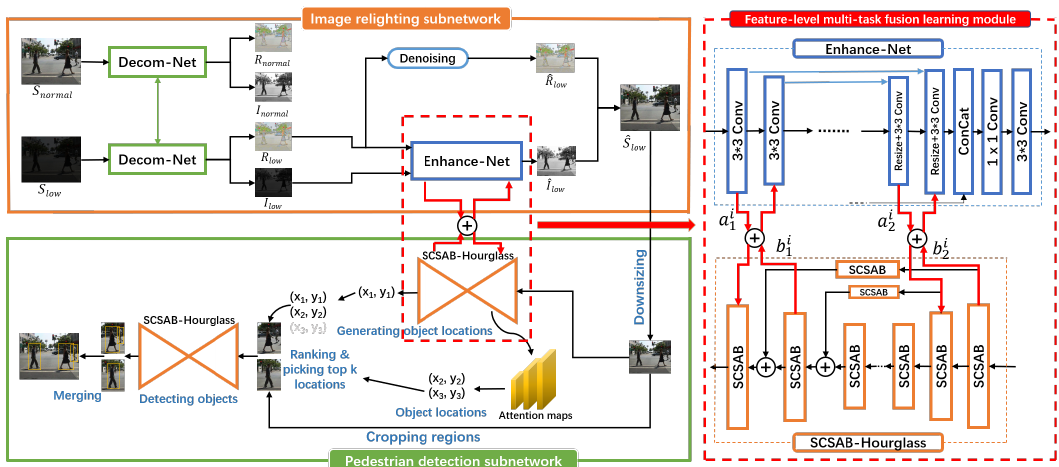
Figure 2. The architecture of SPMF includes three parts: image relighting subnetwork, pedestrian detection subnetwork, and feature-level multi-task fusion learning module. The feature-level multi-task fusion learning module uses feature-level fusion and sharing mechanism to fuse features from two subnetworks, and then shares fused features to these two subnetworks.